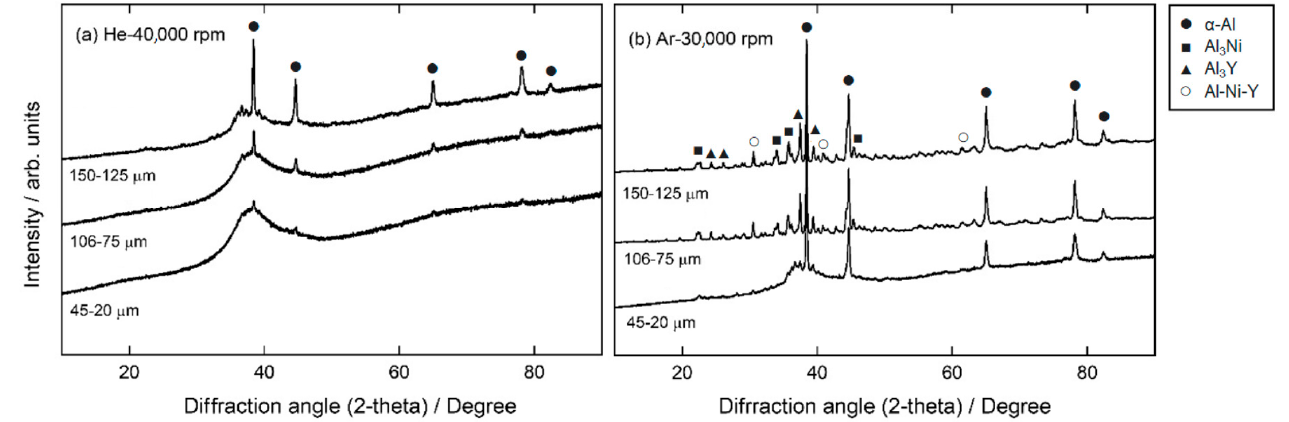
Figure 4. XRD pattern for centrifugally atomized particles: ( a ) particles atomized in a He atmosphere at 40,000 rpm, and ( b ) particles atomized in an Ar atmosphere at 30,000 rpm. The intensity of the crystalline peak increases with increasing particle sizes, indicating a higher crystalline fraction.